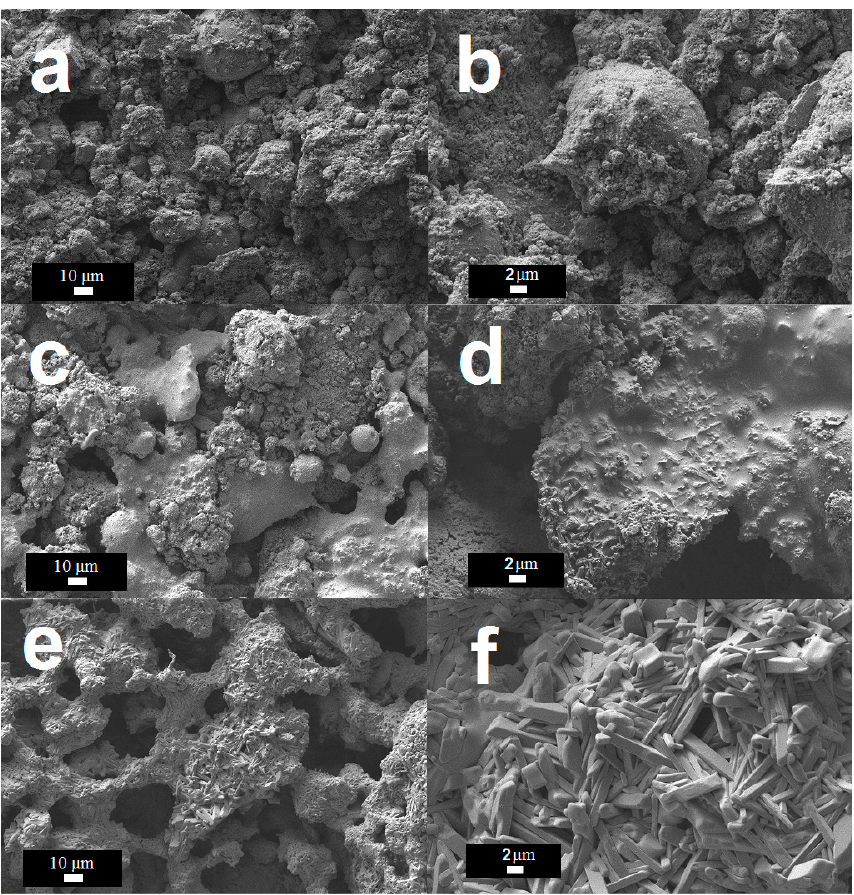
Figure 5. FESEM micrographs of the surface of the mullite precursor coated on substrate, ( a ) no firing (AS); ( c ) fired at 1200 °C (MA); ( e ) fired at 1500 °C (MB) and the closer views of ( b ) AS; ( d ) MA; ( f ) MB.